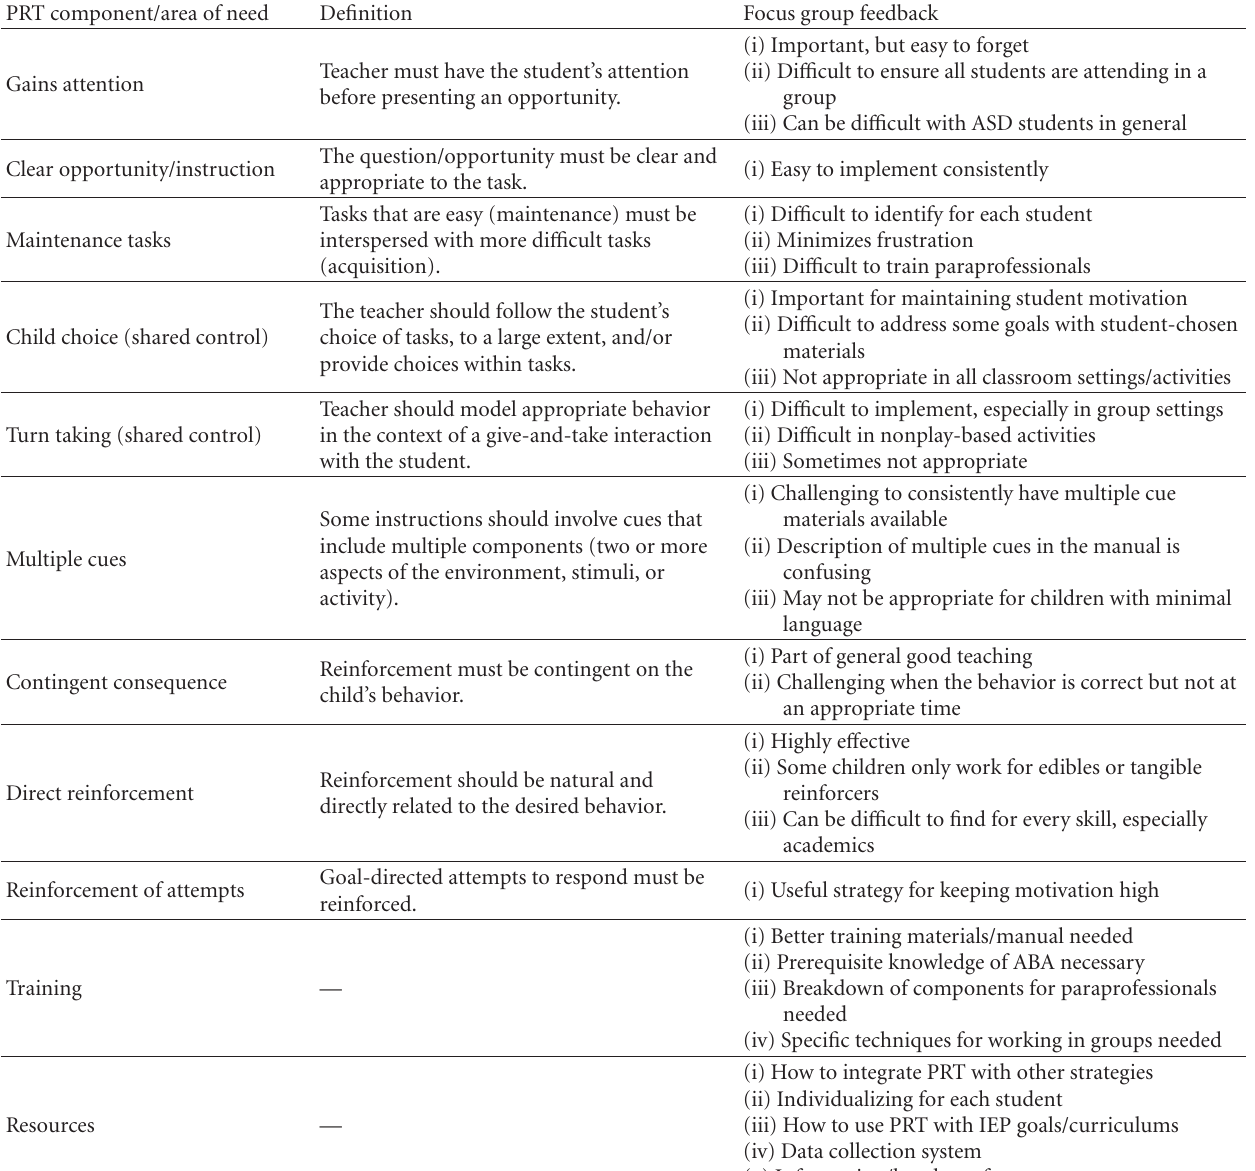
Table 1: Summary of PRT components and focus group